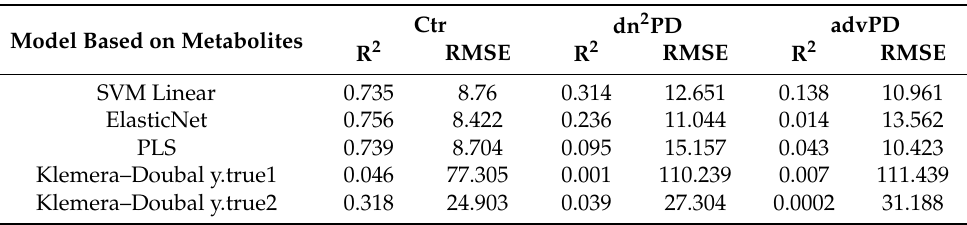
Table 4. Table reporting performance for SVM, PLS, and ElasticNet together with the baseline model of Klemera–Doubal, using metabolites/lipoproteins as input features. Model Based on